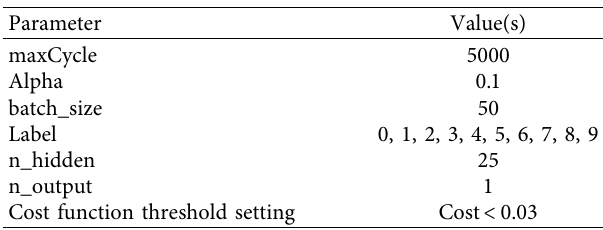
Figure 10: Algorithm flow chart and implementation design. Table 7: Some of the RBF parameters.